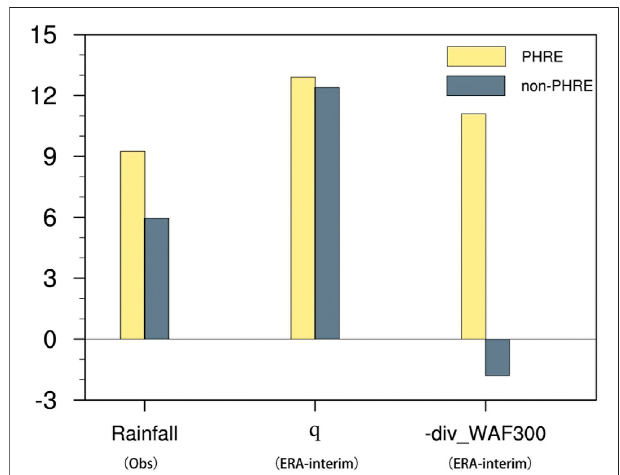
FIGURE 10 | Precipitation (units: mm/d), background speci fi c humidity at 850 hPa (units: g/kg), and divergence of the WAF at 300 hPa (units: 10 − 6 m/s 2 ) averaged over the MLYR. The yellow bars and blue bars denote PHRE years and non-PHRE years,